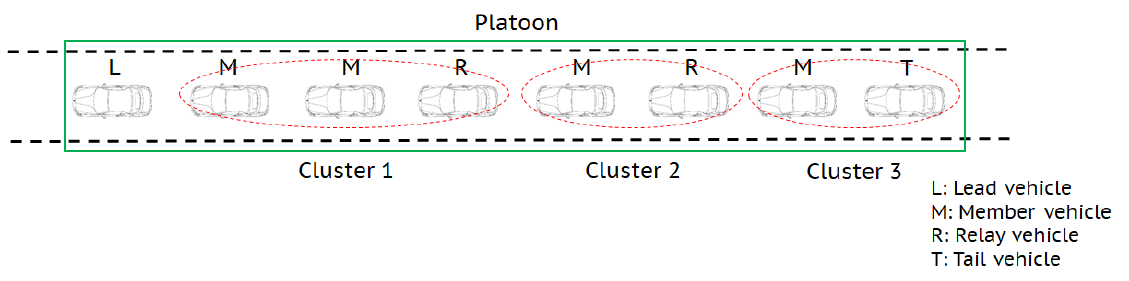
Figure 1. Vehicle platoon communication model ( Λ = 8, K = 3, N 1 = 2, and N 2 = N 3 =